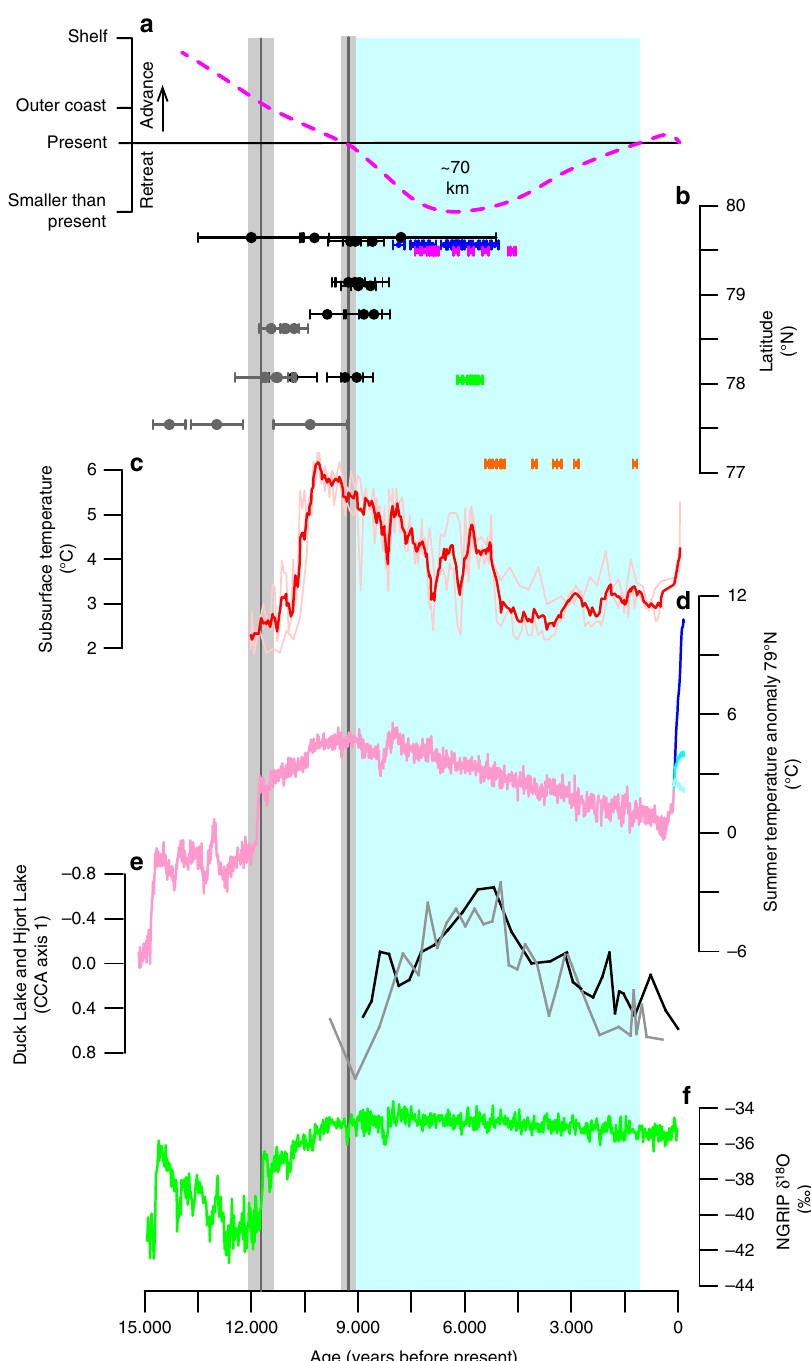
Fig. 2 Ice fl uctuations and climate variability the last 15 kyr. a Reconstruction of ice-margin fl uctuations based on b 10 Be ages with external uncertainties from outer coast (dark gray) and outside the Little Ice Age moraine (black), and 14 C dates from raised marine deposits presently dammed by NEGIS up to 70 km upstream the present ice margin at NG; Blåsø (blue) 27 and Midgaardsormen (pink) 27 , and 14 C dates of reworked shells in Little Ice Age moraines at Søndre Mellemland (green) 27 , and at SG (orange) 28 . Vertical gray bars are the mean and standard error of the outer (older) and inner (younger) 10 Be ages with the production rate uncertainty included. Vertical light blue bar is when the NEGIS is smaller than present. The early Holocene ice-retreat coincides with c peak subsurface temperatures based on planktic foraminiferal fauna assemblages (SST100) 32 and d peak summer temperature (JJA) (pink) at 79°N with RCP 2.6 (light blue), 4.5 (blue), and 8.5 scenarios (dark blue) 31 . e The timing of maximum mid-Holocene ice retreat coincides with local chironomid- based temperature maxima at Duck (black) and Hjort (grey) lakes on Store Koldeway in Northeast Greenland 39 . f Ice core δ 18 O record from NGRIP